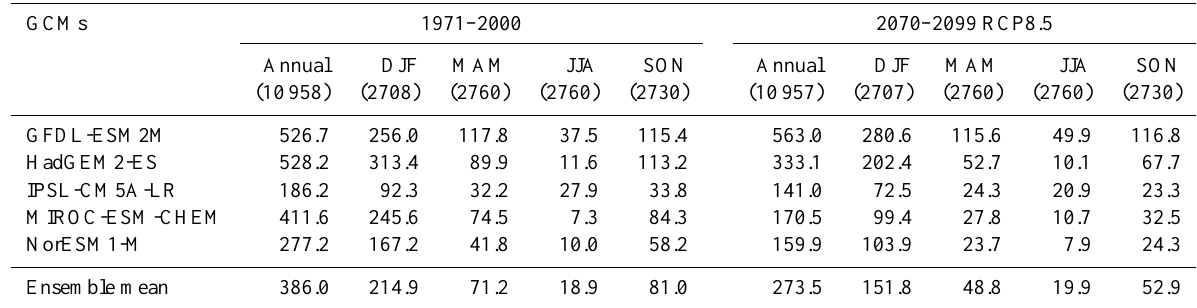
Table 2b. Total number of days when the humidity is truncated at 100%RH during adjustment by our primitive bias correction described in Sect. 2.4.2. Both the annual and seasonal sums are given by the mean over all land cells (67420 cells). The total numbers of days are given in parentheses in the